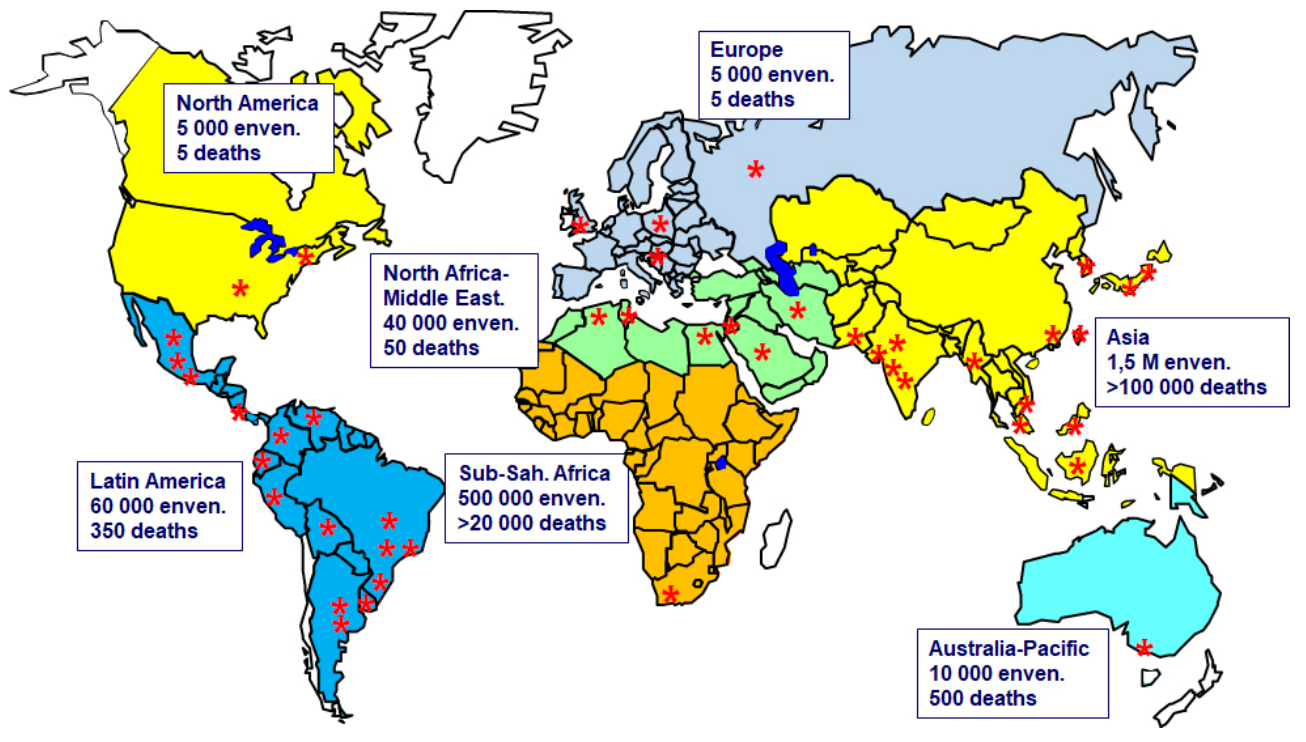
Figure 1. Global distribution of antivenom manufacturers (indicated by red